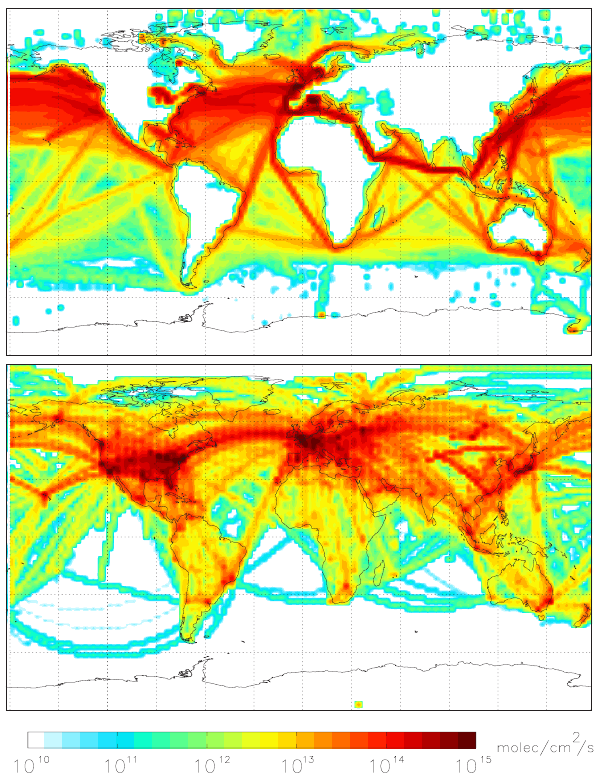
Fig. 3. CO 2 emissions from international shipping for the year 2006 (top). CO 2 emissions from international and domestic aviation for the year 2006